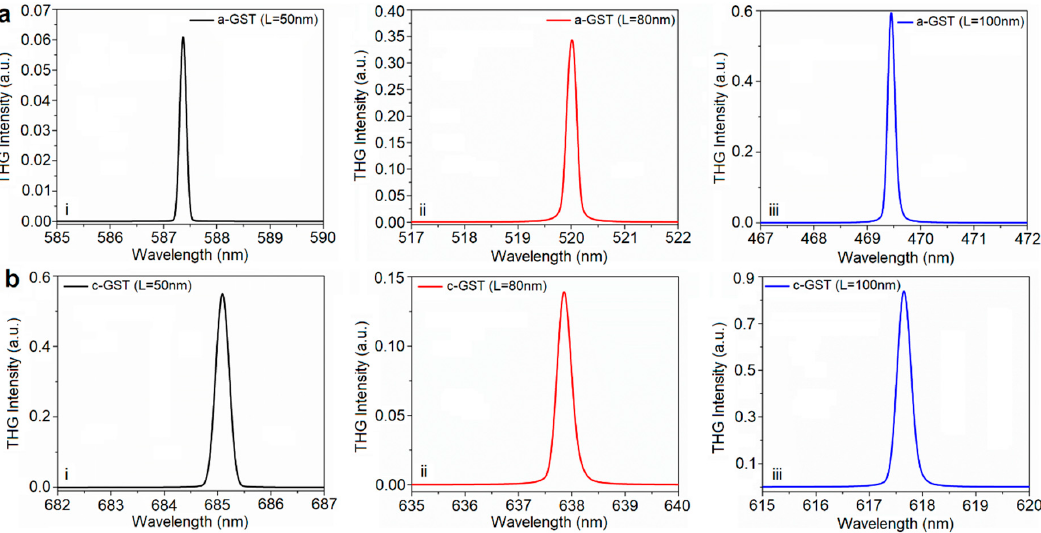
Figure 4. The third harmonic emission spectrum of ( a ) a-GST and ( b ) c-GST cases for the variations in L: ( i ) 50 nm, ( ii ) 80 nm, and ( iii ) 100 nm.